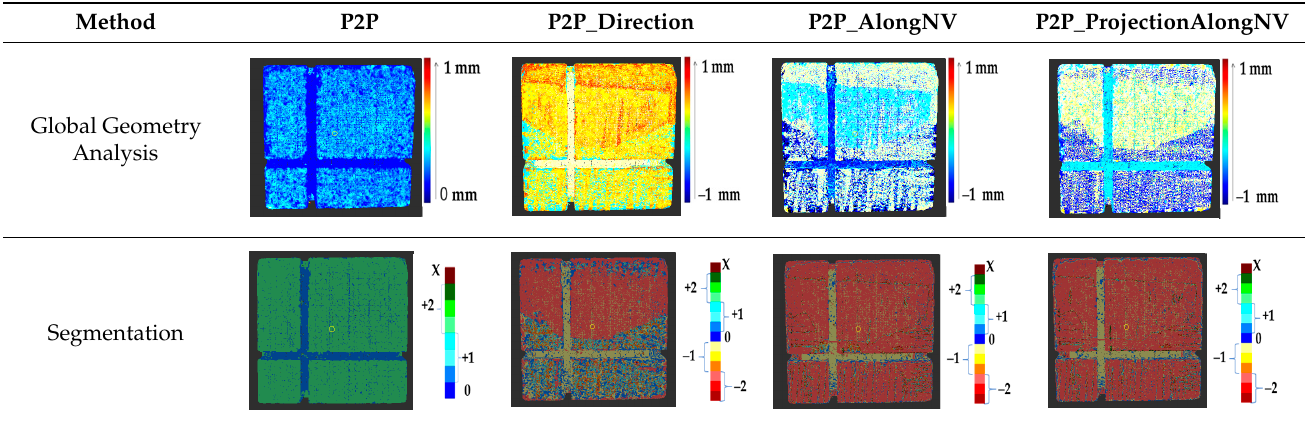
Table 11. Analysis and results for the dataset of EL3.